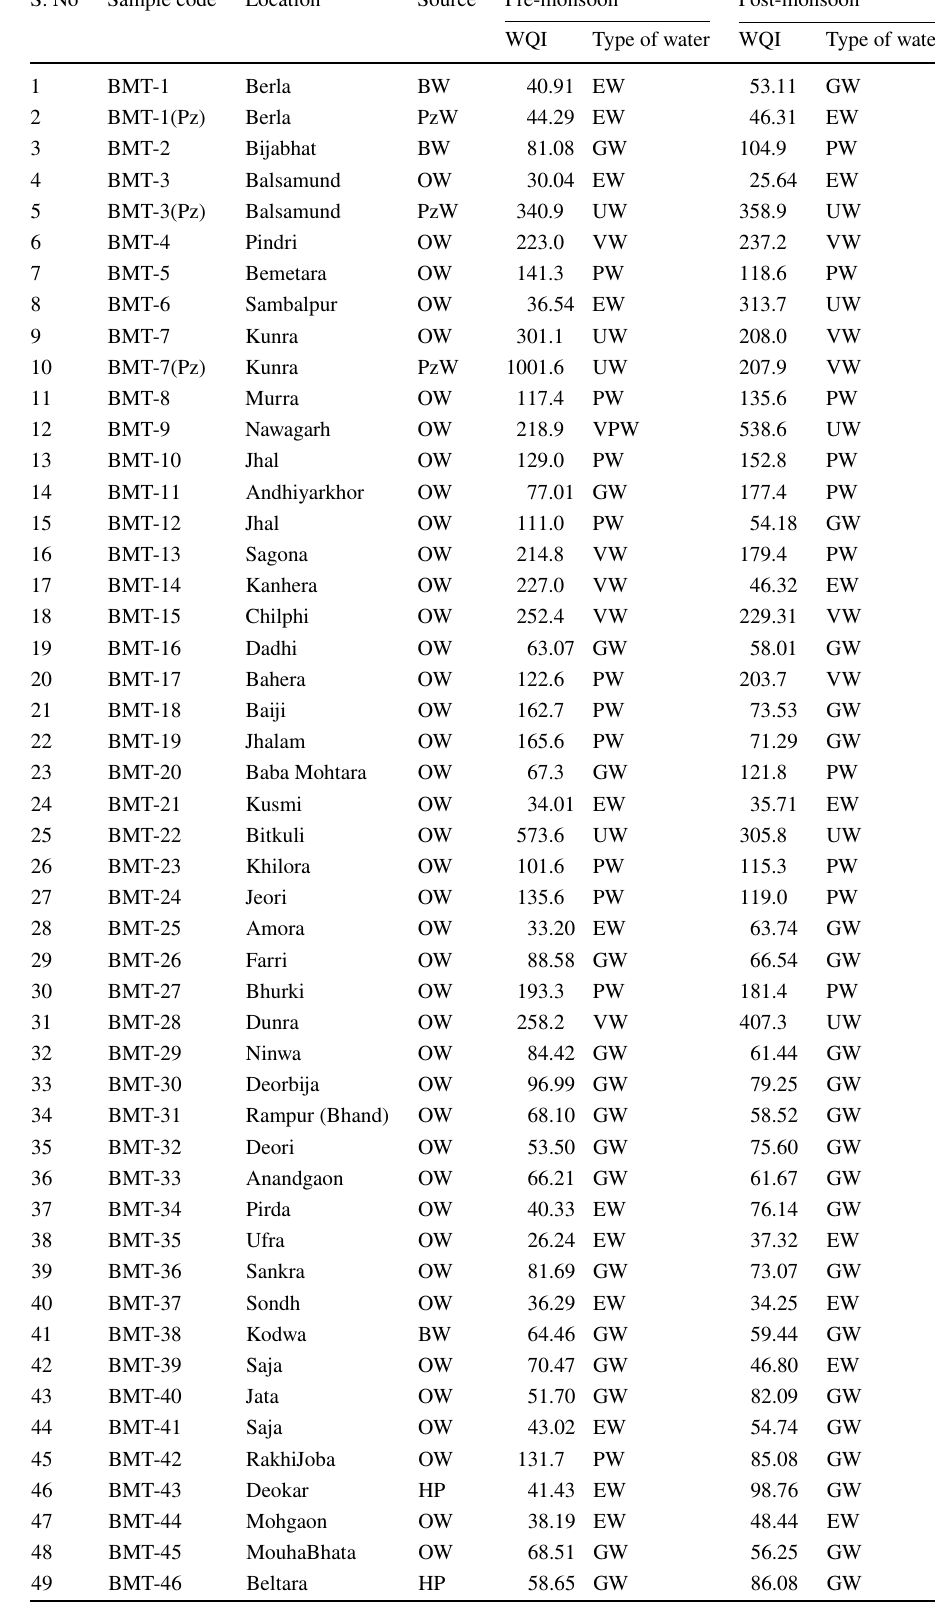
Table 8 WQI of groundwater of study area (pre- and post- monsoon